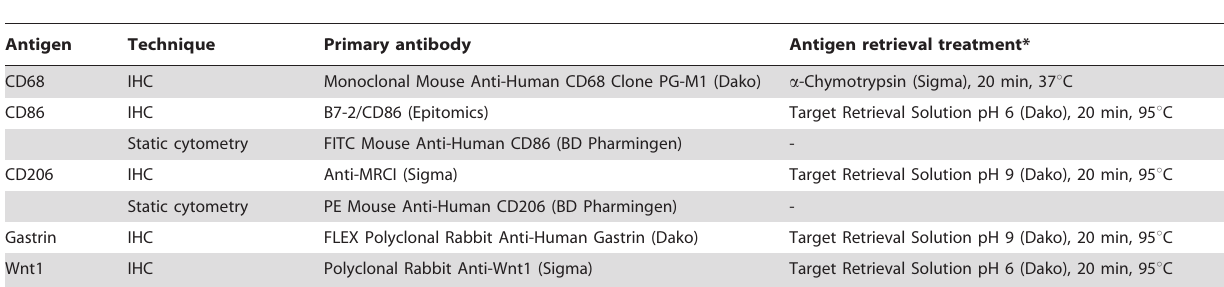
*Procedure to unmask the antigen. doi:10.1371/journal.pone.0098458.t002 PLOS ONE |